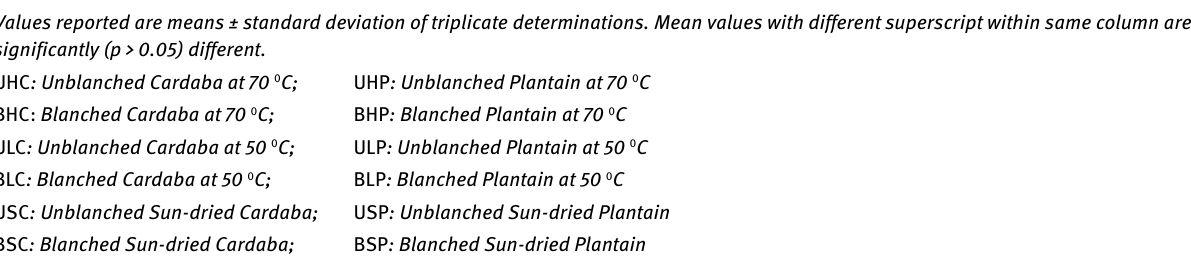
Values reported are means ± standard deviation of triplicate determinations. Mean values with different superscript within same column are significantly (p > 0.05)